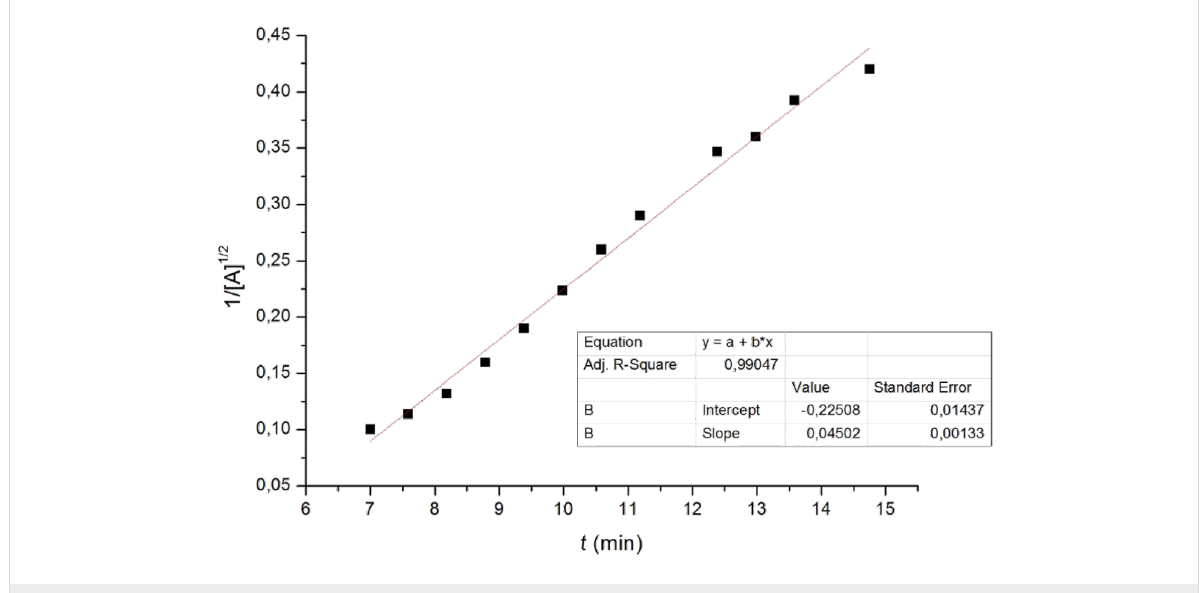
Figure 4: Plot of vs time for the dimerization of azlactone 1a